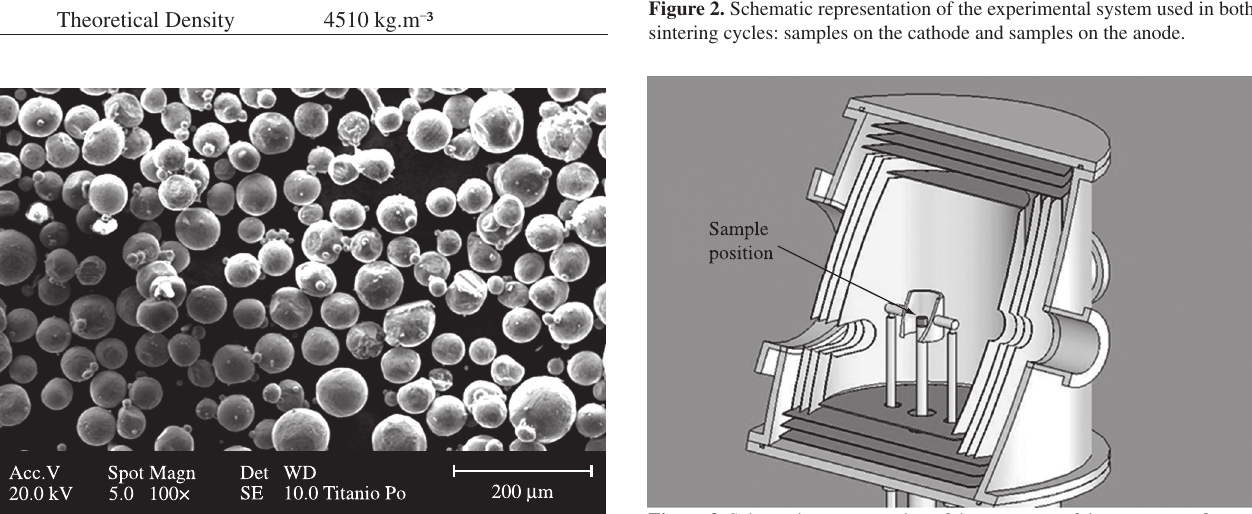
Figure 3. Schematic representation of the geometry of the reactor configura- tion CAC indicating the position of the